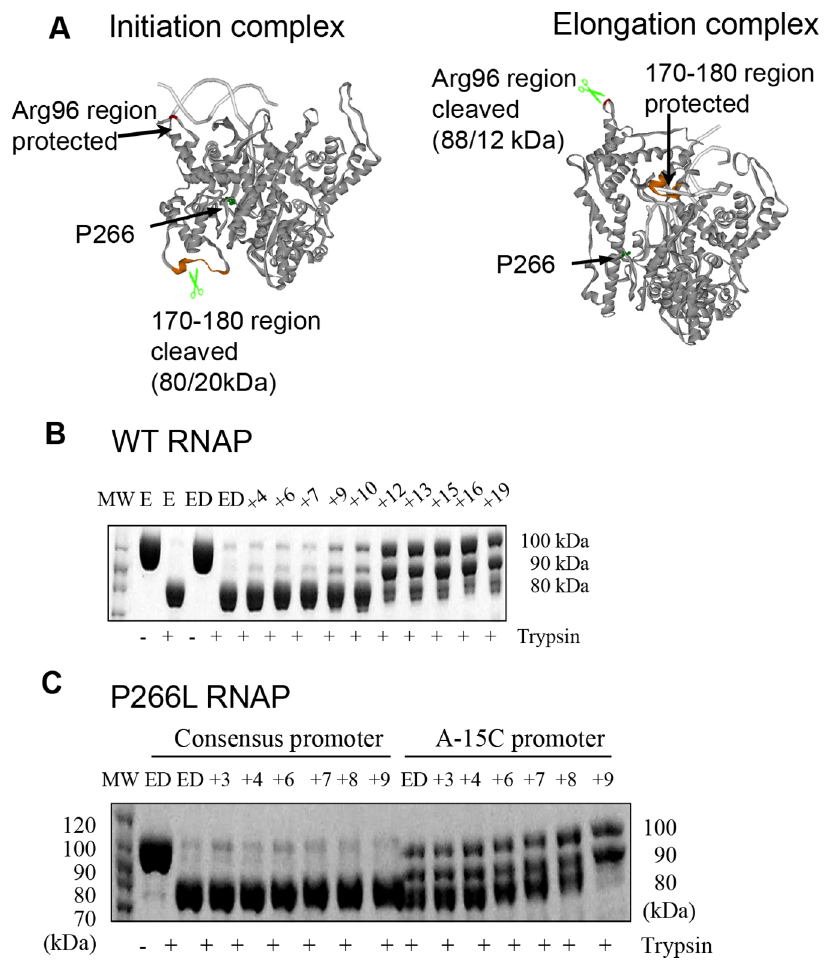
Figure 4. Subdomain H refolding is delayed in the P266L mutant. (A) T7 RNAP in initiation and elongation conformations have different exposure of Arg 96 (red color) and residues 170–180 (brown color) to trypsin digestion. Formation of an elongation complex is characterized by the disappearance of the 80 kDa fragment and the appearance of the 88 kDa fragment. P266 is colored in green. Limited trypsin digestion (15 s) of WT T7 RNAP after walking to + 4 to + 19 positions. E- RNAP, ED- RNAP:promoter complex (C) Same experiment as in panel B was carried out with P266L and consensus or A-15C promoter. The digestion pattern with the A-15C promoter shows that transition to EC occurs at + 9 in the A-15C promoter, but not with the consensus